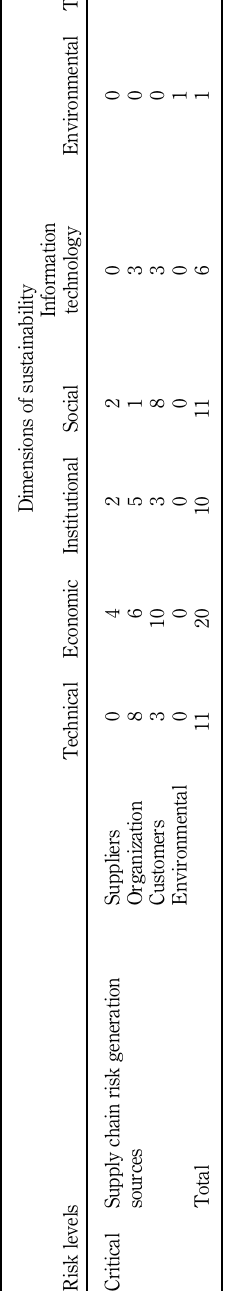
Table 4. Distribution of critical risks by supply chain production resources and sustainable development